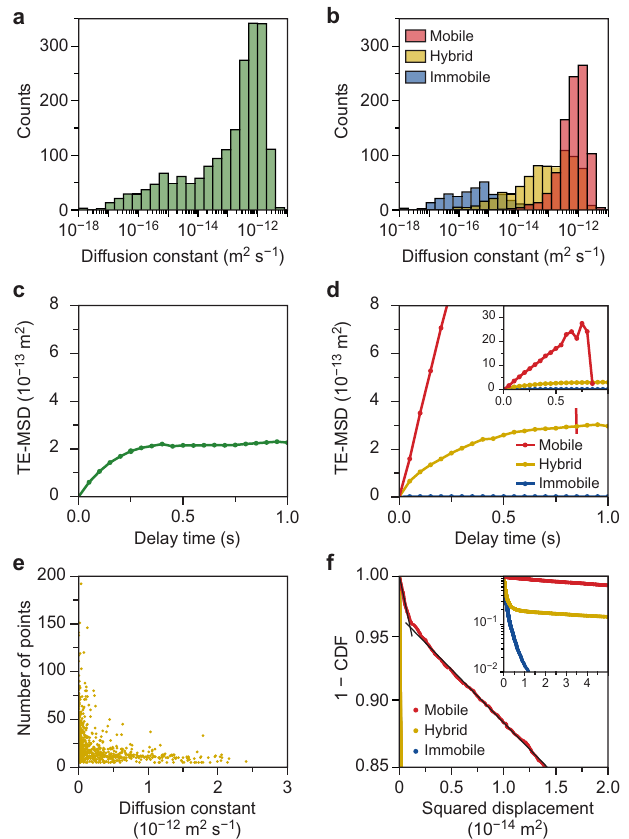
Figure 3. ( a , b ) Histogram of the measured diffusion constant as obtained by time-averaged mean squared displacement (T-MSD) analysis per trajectory ( a ) before and ( b ) after classification. Negative measured diffusion constants are not displayed in the logarithmic scale. ( c , d ) Zoom of the time–ensemble averaged mean squared displacement (TE-MSD) ( c ) before and ( d ) after classification. A zoom-out is shown in the inset in ( d ). ( e ) Correlation plot of the diffusion constant and number of points of the hybrid population. Each dot represents a single trajectory. ( f ) One minus the cumulative distribution function (CDF) of squared displacements for a delay time of one frame of all trajectories plotted with a logarithmic y -axis. The colours indicate the populations after classification. The solid black lines are a guide to the eye to indicate two regimes in the cumulative density probability of the mobile trajectories. A zoom-out is shown in the